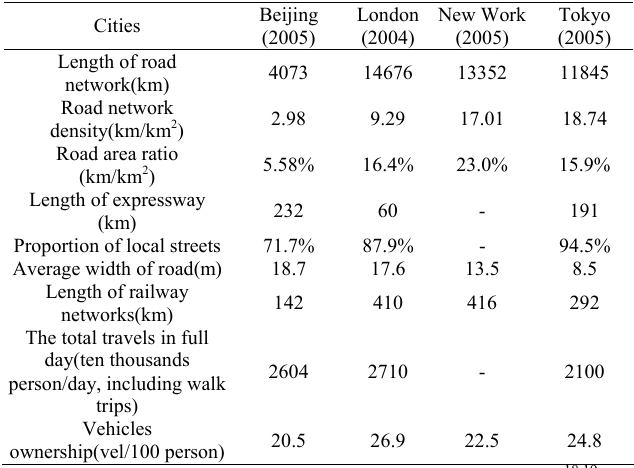
Table 2. Traffic infrastructure of four